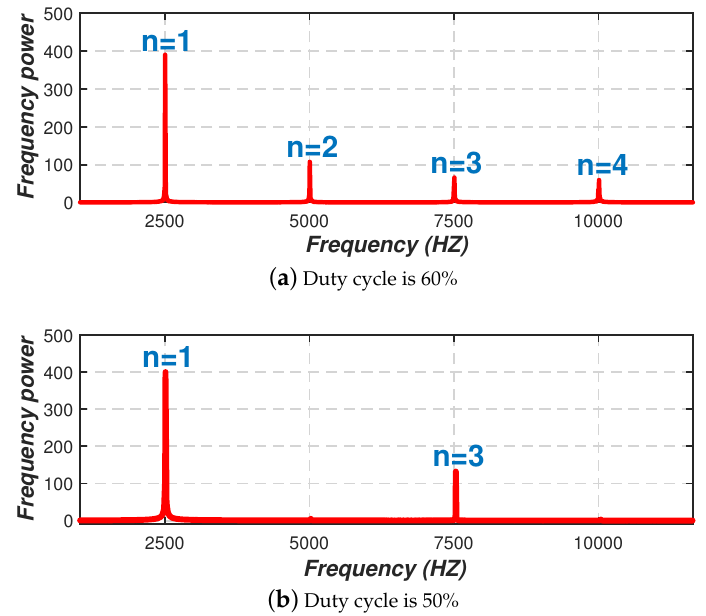
Figure 3. Relationship between duty cycle and number of harmonics.